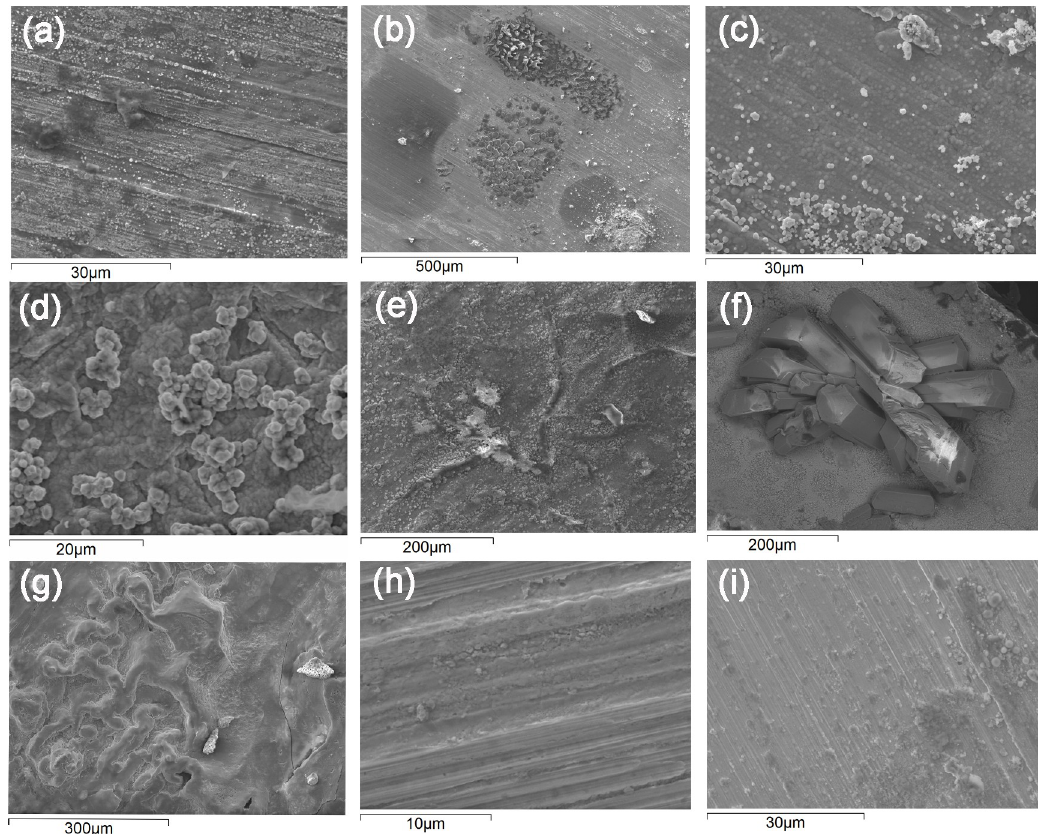
Fig 5. Selected SEM-SE top-surface images of the corrosion product layer of Cu coupons after 2 weeks of daily fingerprint contact and continous daily cycles of repeated dry/wet periods at constant temperature (a) compared with parallel exposures with daily deposition of ASW on Cu metal coupons after 1 day (b-d) and 4 weeks (e-g) and non-ASW-deposited Cu metal coupons after 1 day (h) and 4 weeks (i) of exposure in the climatic chamber.